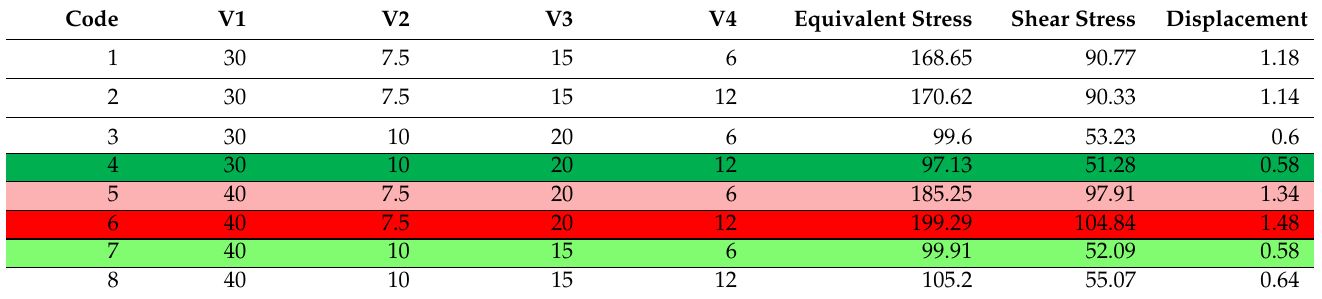
Table 3. Parameter values (equivalent stress, shear stress, displacement) obtained by applying